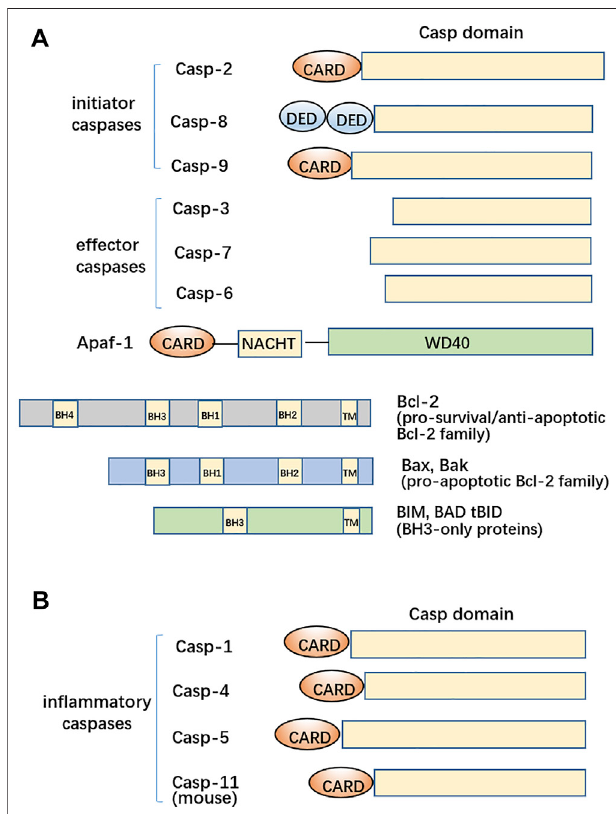
FIGURE 1 | Structural features of caspases, Apaf-1, and the Bcl-2 family. (A) Master initiator caspases, caspase-2, caspase-8, and caspase-9, are characterized by N-terminal domain(s) including DED or CARD. The effector caspases have caspase-3, caspase-6, and caspase-7 for apoptosis. Apaf-1 is a main scaffold protein for recruitment of Cyt c and caspase-9. Bcl-2 itself plays anti-apoptotic roles whereas the Bax/Bak membersoftheBcl-2familyarepro-apoptotic.BH3-onlyproteinisanintrinsic apoptosis initiator. (B) Another clade contains in fl ammatory caspases, including human caspase-1, -4, and -5 and mouse caspase-11, have the N-terminal CARD domains.